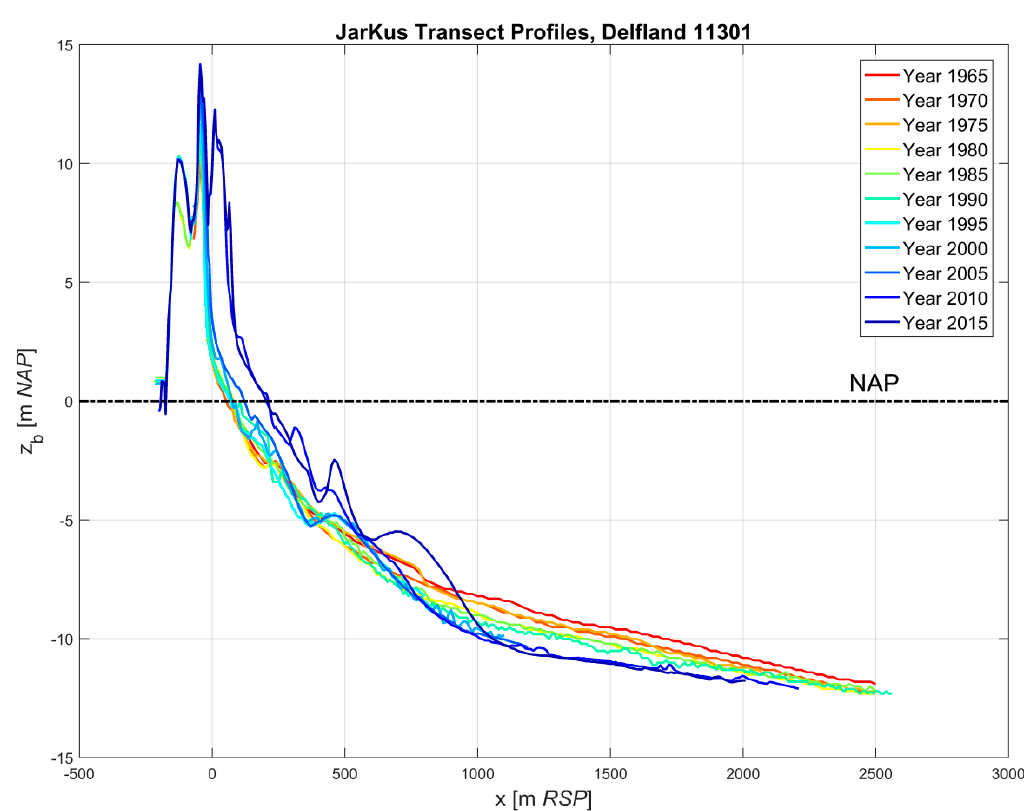
Figure 3. Example of the morphological development of a single cross-shore JarKus profile (transect 11,301) located at Delfland, between 1965 and